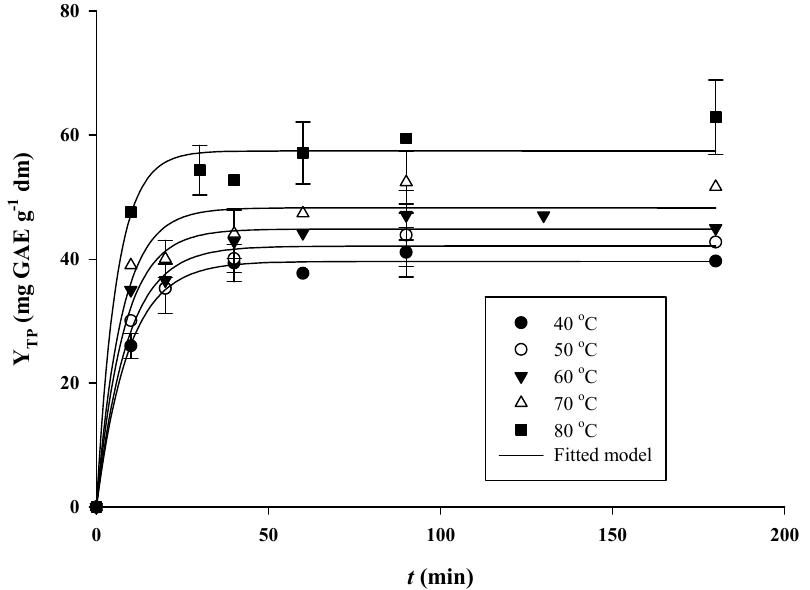
Figure 4. Kinetics of total polyphenol extraction under optimized conditions ( C CD = 1.5%, t us = 30 min, R L/S = 90 mL g − 1 ). Extractions were performed under stirring at 900 rpm, for 180 min. Table 3. Kinetic data for polyphenol extraction from RGP, carried out under optimized conditions. T (°C) Kinetic Parameters and Activation Energy